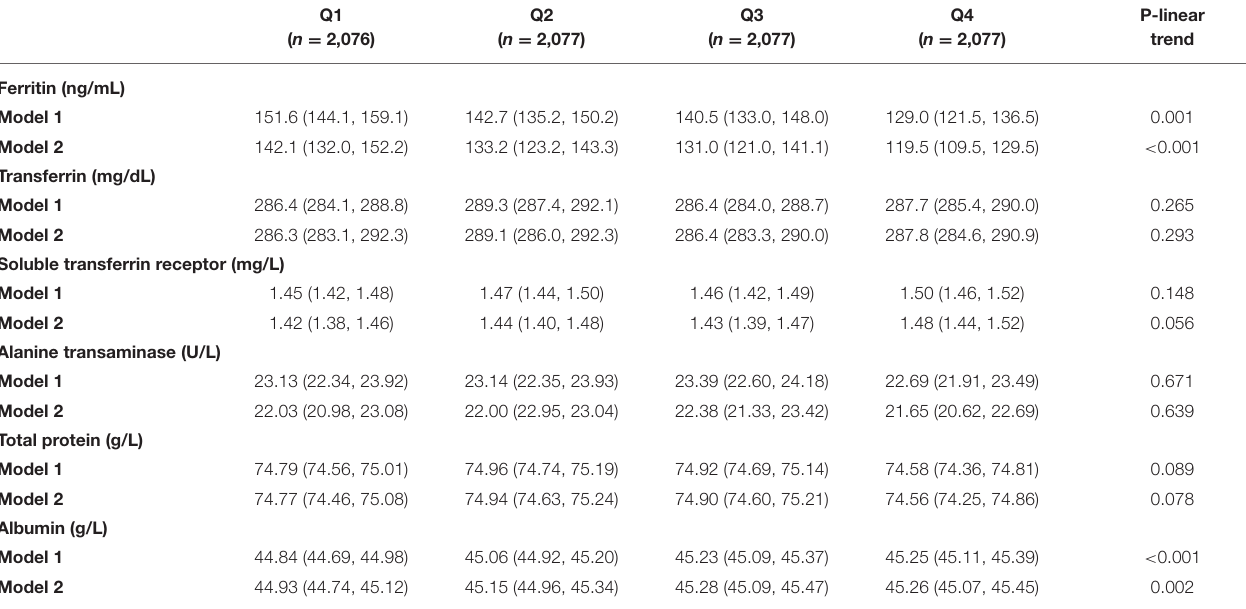
TABLE 2 | Estimation mean (95% CI) of biomarkers of liver function according to dietary vitamin C intake (mg) among